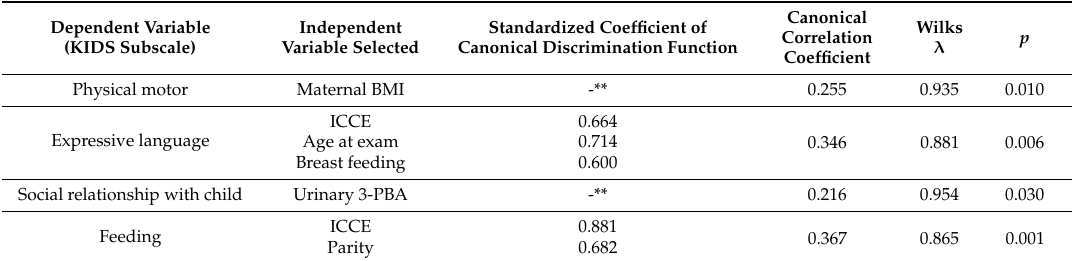
Table 5. Results of stepwise discriminant analyses * (Model